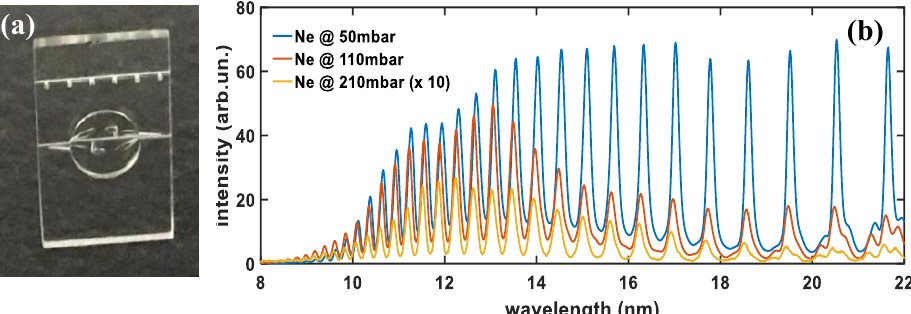
Figure 1 (a) Fused silica device endowed with a micro-channel fabricated by FLM. (b) HHG spectra generated inside the chip using Neon gas with a backing pressure of 50 (blue), 110 (red) and 210 mbar (yellow); this latter curve is magnified 10